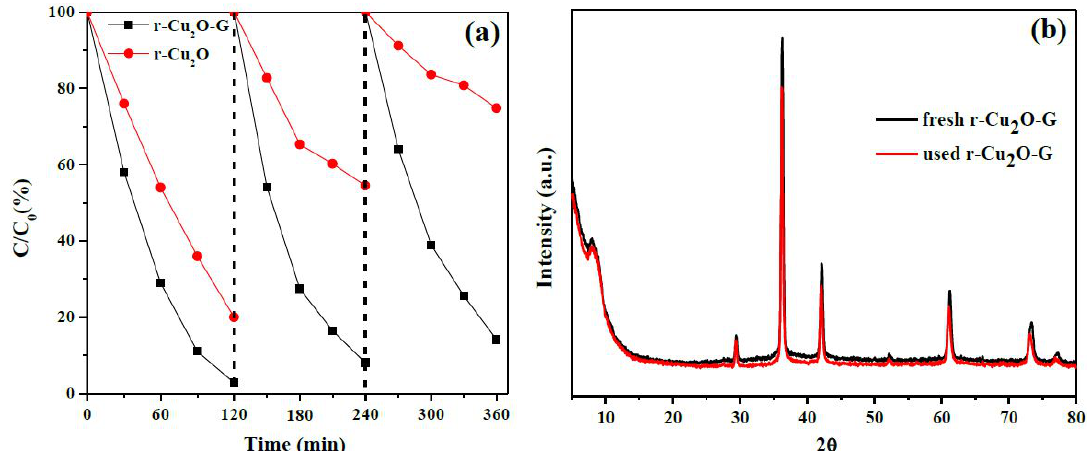
Figure 7. ( a ) Cyclic tests of r-Cu 2 O and r-Cu 2 O-G photocatalysts for MO photodegradation under visible light; ( b ) XRD patterns of the fresh and used r-Cu 2 O-G.